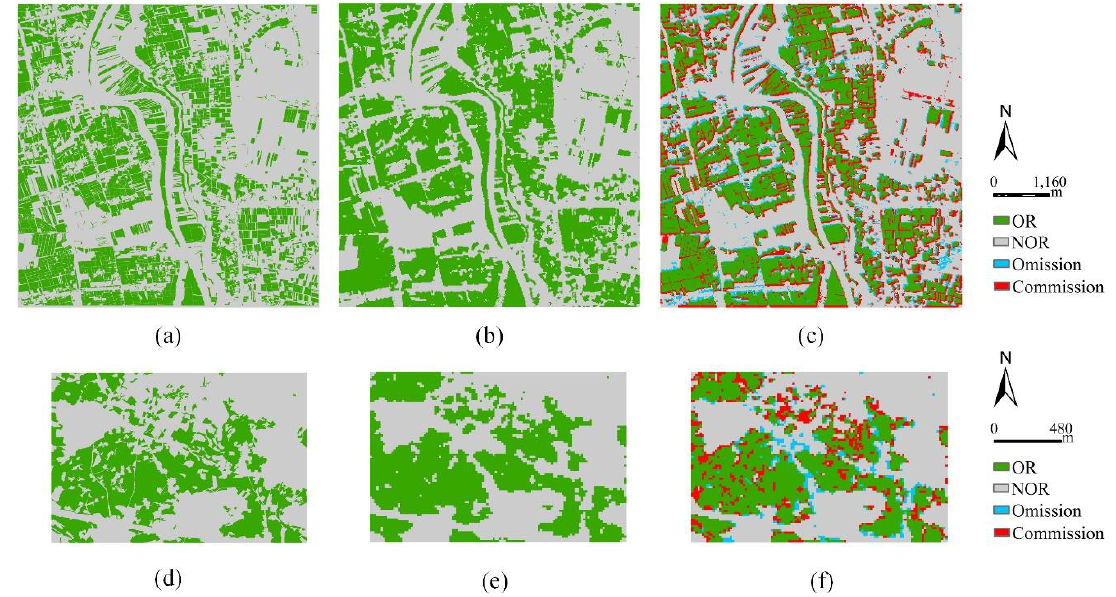
Figure 11. The CSRA-derived oilseed rape planting maps of Hubei Province in ( a ) 2014; ( b ) 2015; ( c ) 2016; and ( d ) 2017.